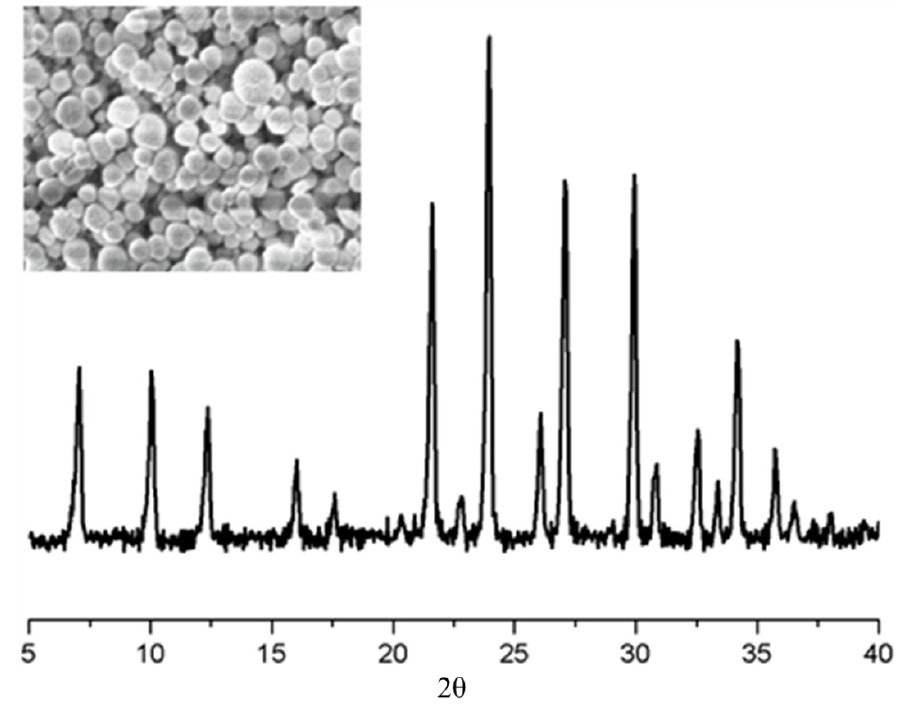
Figure 2. XRD pattern of LTA crystals as synthesized (inset: SEM of LTA